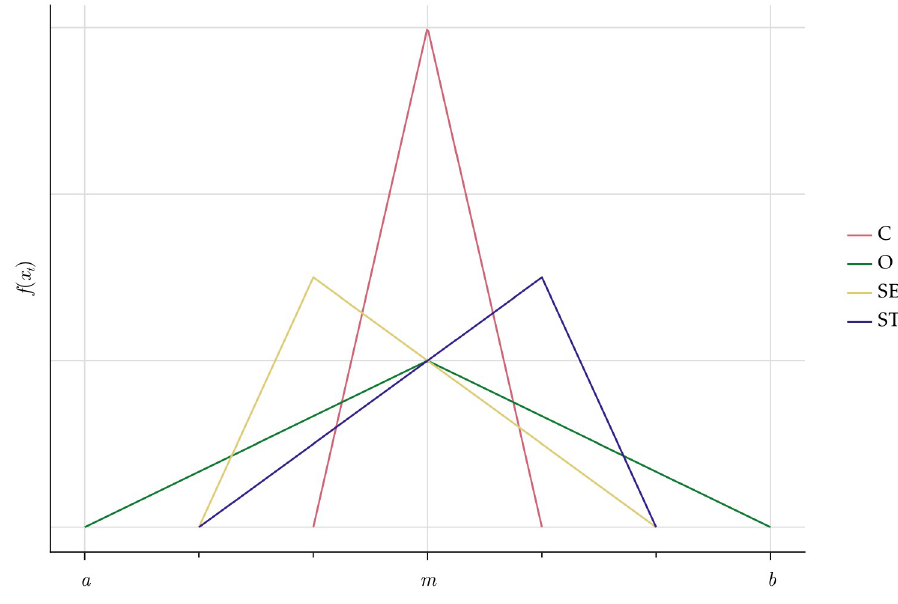
Fig 5. Density functions for cooperativeness.